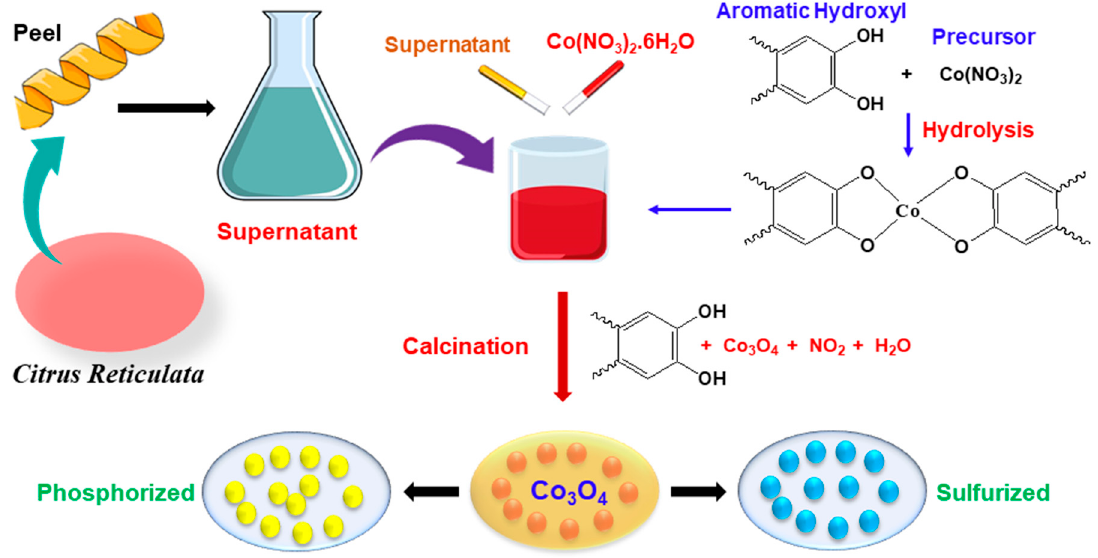
Figure 1. Schematic diagram of the synthesis of nanoparticles, along with the chemical mechanism of Co 3 O 4 nanoparticle formation.